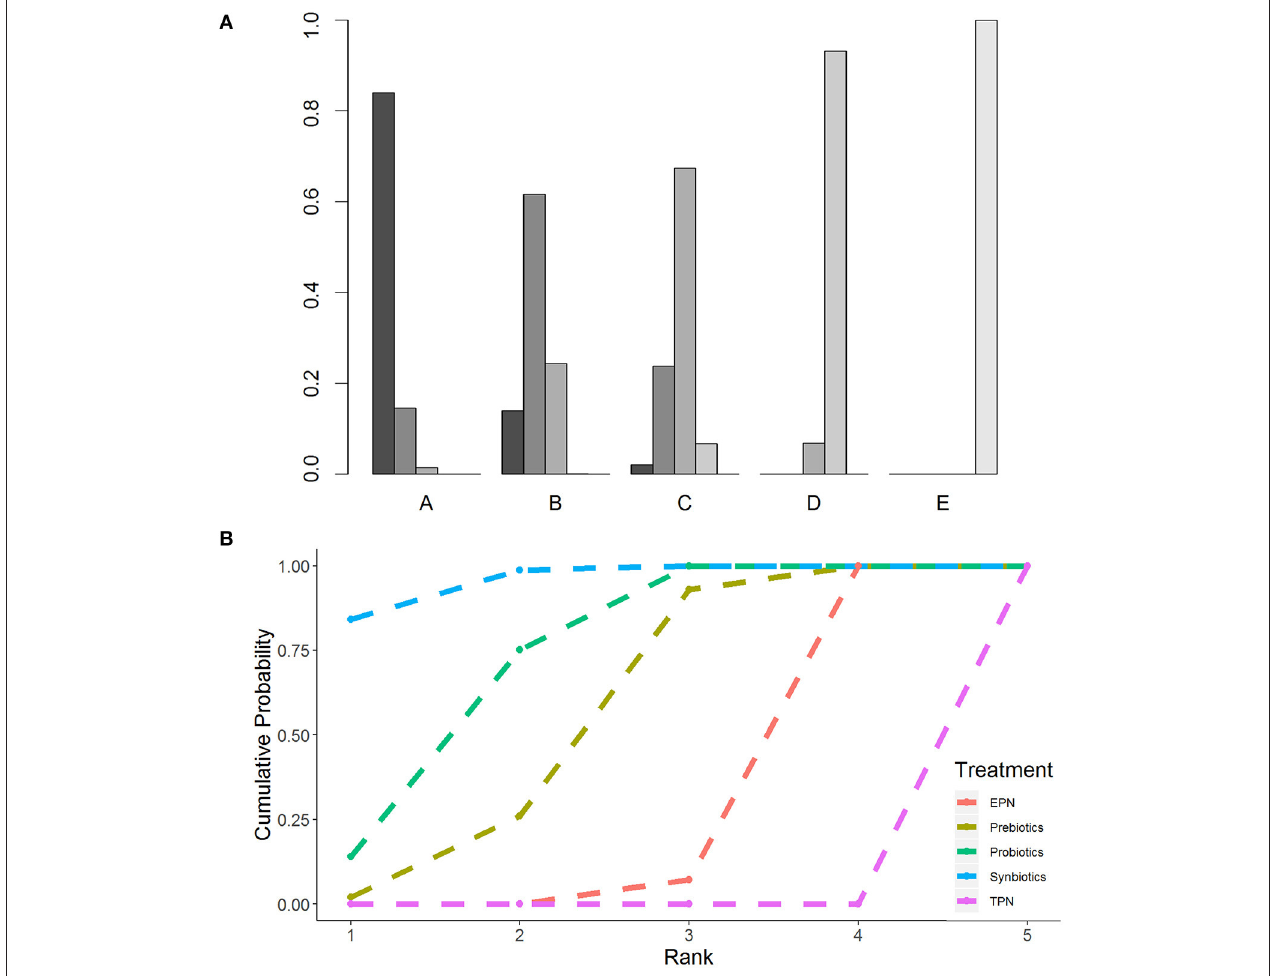
FIGURE 5 | Rankogram and SUCRA ranking curve for nosocomial infection. (A) Rankogram for nosocomial infection. A = Synbiotics. B = Probiotics. C = Probiotics. D = EPN. E = TPN. (B) SUCRA ranking for nosocomial infection. The number on the X-axis represents the rank. As the number goes up, the rating goes down. EPN, Enteral nutrition or adjuvant peripheral parenteral nutrition; TPN, Total parenteral nutrition.